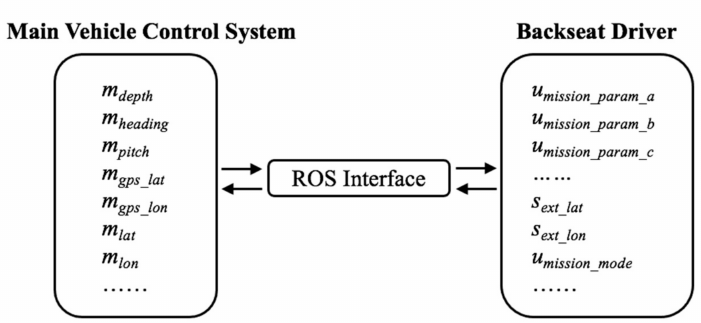
Figure 4. Data exchange between the main vehicle control system and backseat driver.